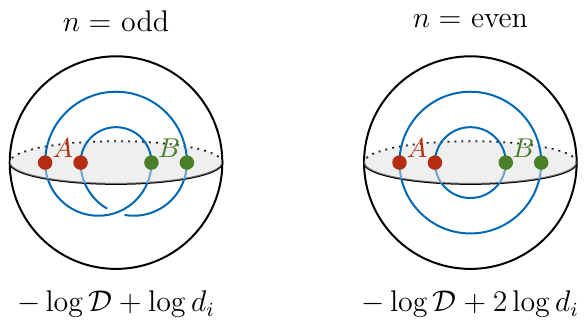
Figure 6 . The partition function for the pseudo entropy with n odd and even and their values. In the odd case, we can interpret that the two states are related by the entanglement swapping. In the even case, it can be regarded as two copies of entangled